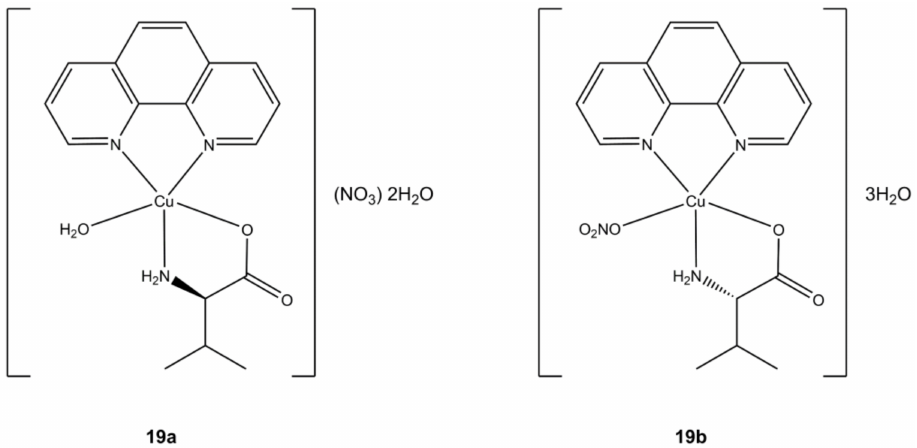
Figure 19. Structure of the [Cu(L-dipeptide)(phen)] · nH 2 O complexes. Acilan et al. prepared a series of [Cu(Sal-Gly)(N-N 4 )] complexes (Figure 20), where Sal-Gly is the O,N,O Schiff Base obtained from Salicylaldehyde and Glycine, while the N-N 4 ligands are phen, 1,10-phenanthroline-5-amine, 5,6-diepoxy-1,10-phenanthroline [58].